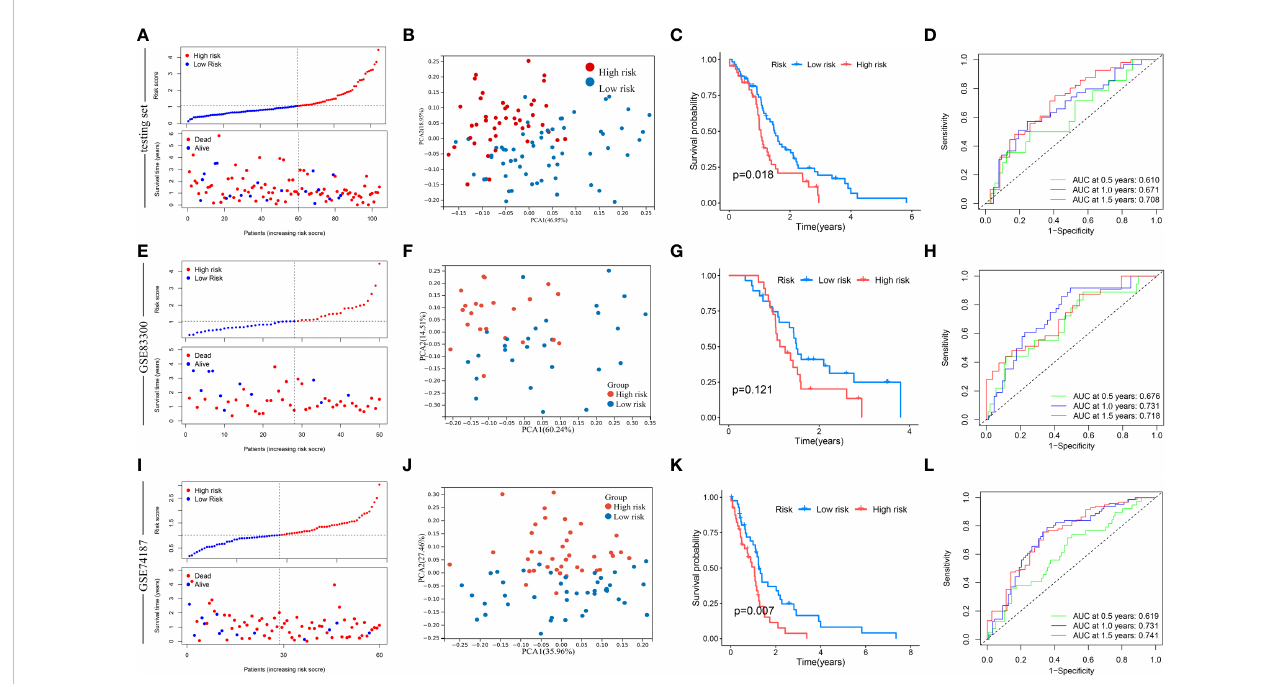
FIGURE 7 Validation of risk score in the testing set, GSE83300 cohort, and GSE74187 cohort. (A, E, I) The ranked dot plot indicates the risk score distribution, and the scatter plot presents the patients ’ survival status. (B, F, J) The PCA analysis based on the prognostic signature demonstrated that the patients in the different risk score groups were distributed in two directions. Red and blue dots represent the high-risk group and the low-risk group. (C) Kaplan-Meier curves for OS of the two risk groups (chi-square test, p = 0.018). (G) Kaplan-Meier curves for OS of the two risk groups (chi-square test, p = 0.121). (K) Kaplan-Meier curves for OS of the two risk groups (chi-square test, p = 0.007). (D, H, L) ROC curves to predict the sensitivity and speci fi city of 0.5-, 1.0-, and 1.5-year survival according to the risk score.